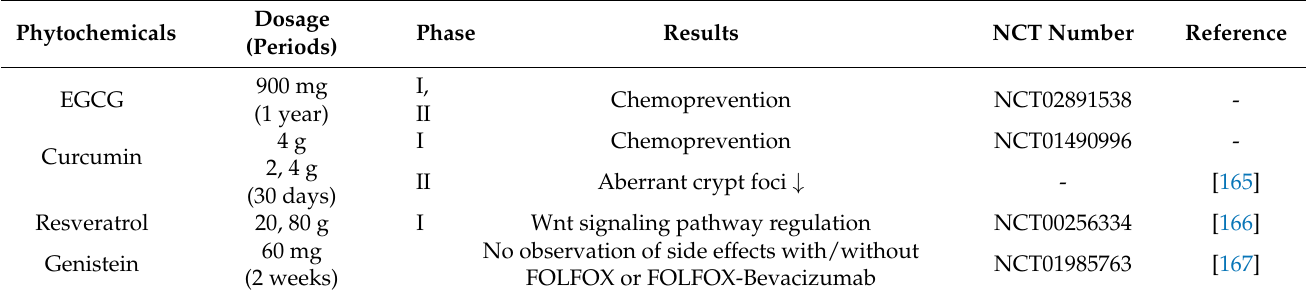
Table 3. Clinical trials on phytochemicals in patients with colorectal